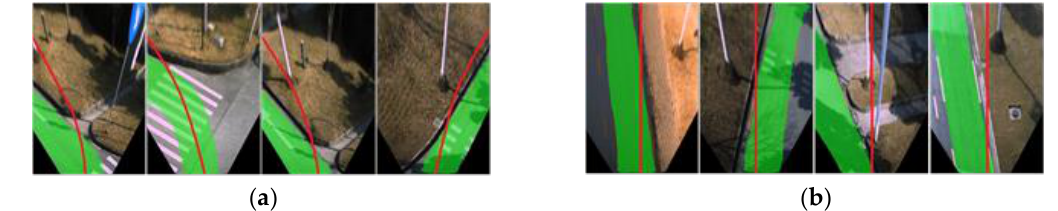
Figure 10. Robustness against conversion and fusion errors: ( a ) Detection results in the presence of